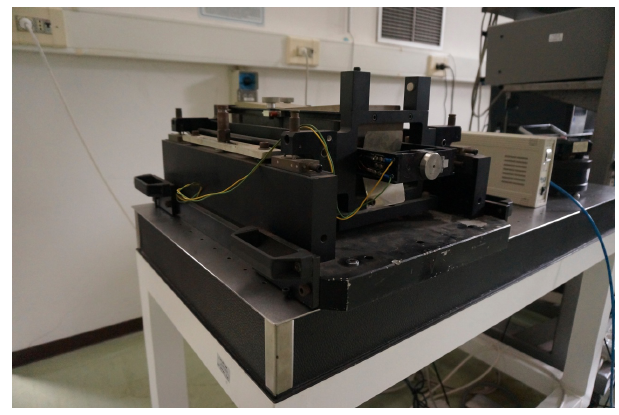
Figure 3. APS 113 ELECTRO-SEIS horizontal vibrating